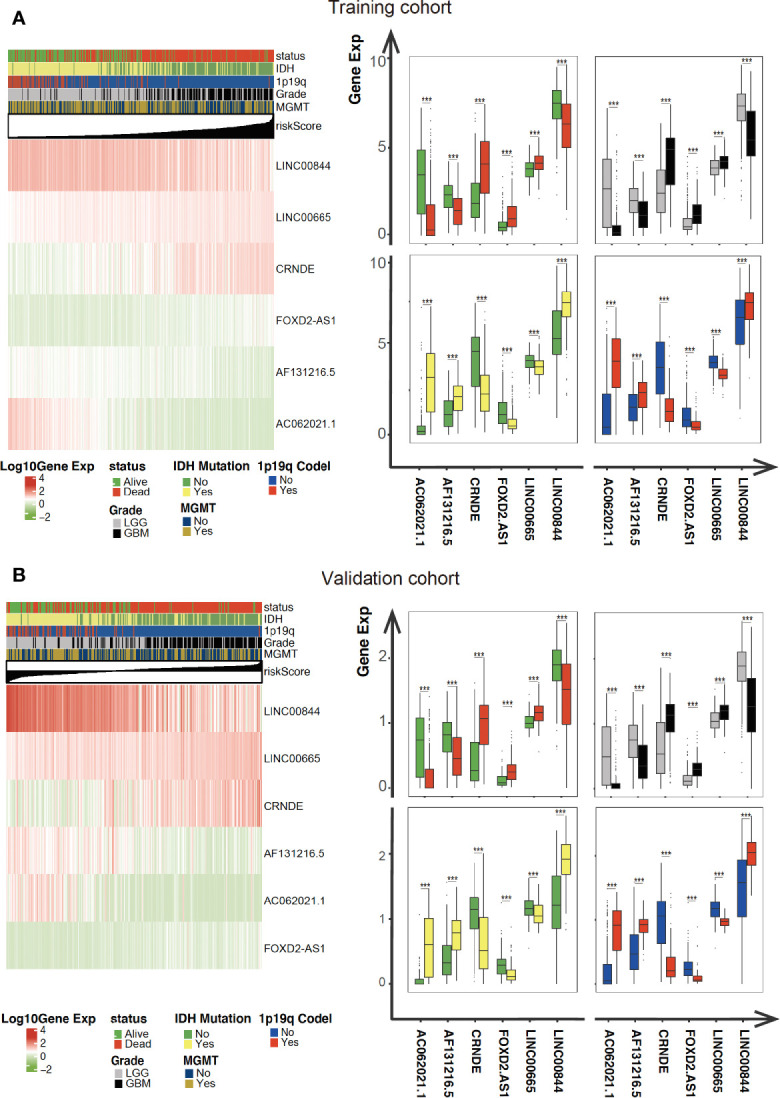
Expression of the mentioned glycolysis-related LncRNAs is correlated with clinicopathological features and prognosis of gliomas. (A, B) Heatmaps showing the expression levels of six LncRNAs in gliomas with different groups. ***P < 0.001.